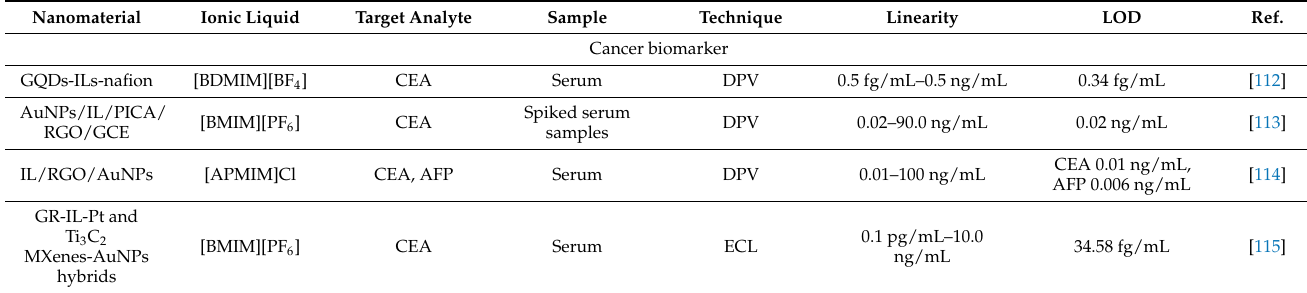
Table 2. Ionic liquids-carbon hybrid nanoparticles-based common electrochemical sensor and biosensor for detection of relevant